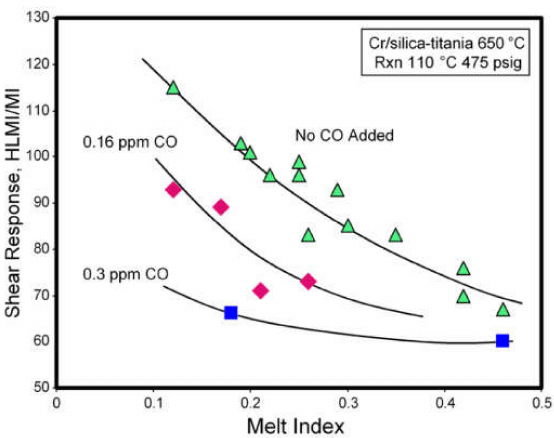
Figure 7. Adding CO to the reactor diminishes the shear thinning ability of the resin (HLMI/MI) due to lowered LCB.